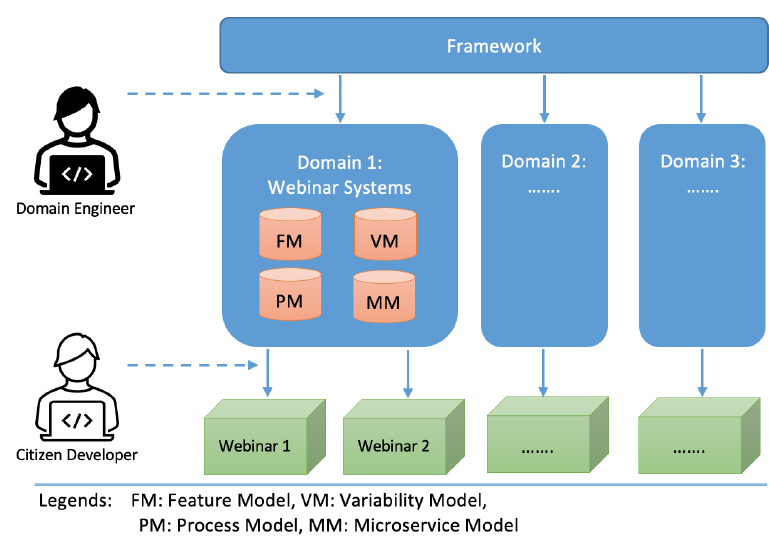
Figure 2. Usage of architectural components in MSDeveloper. The transition from feature-model layer to process-model layer and the transition from the process-model layer to the microservice layer are explained